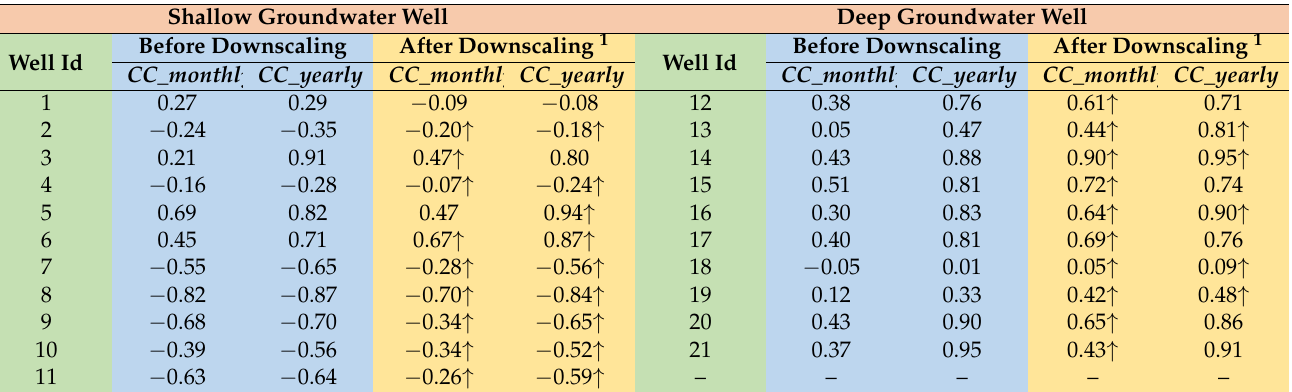
Figure 13. Time series of GWLA and GWSA after downscaling in Guantao County. Table 2. CC of GWSA and GWLA on the monthly and yearly time